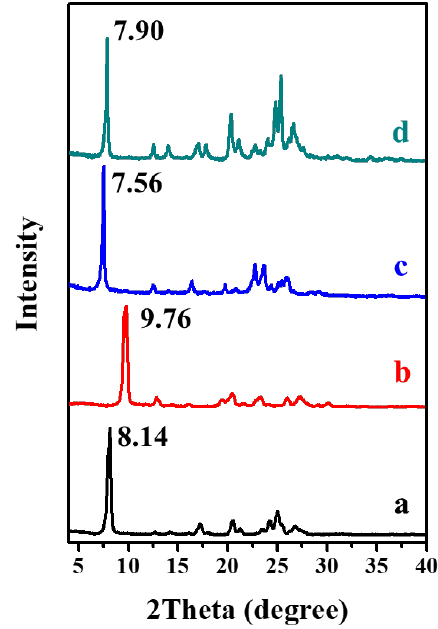
Figure 2. XRD patterns of ( a ) RUB-36, ( b ) RUB-37, ( c ) Sn-JHP-1 and ( d ) Sn-JHP-2. Table 1. Parameters of the